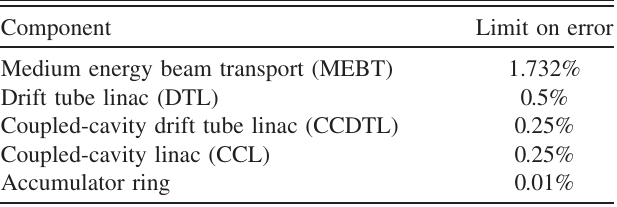
TABLE I. Values of quadrupole gradient error limits for vari- ous components of the SNS linac and accumulator ring [20,21].